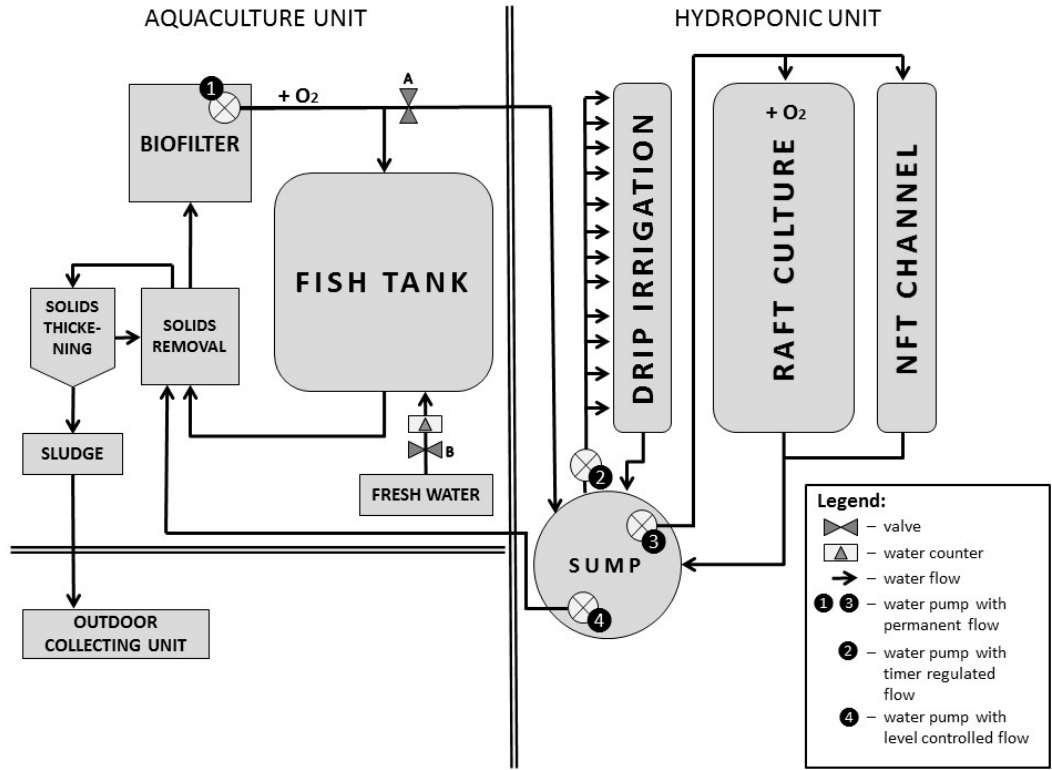
Figure 2. Water flow in the “Wädenswil aquaponic system” in 2014: Fresh water flowed through valve B, which was controlled by UrbanFarmers controller software (UrbanFarmers, Zurich, Switzerland), and an analogue counter to control the volume of water added to the fish tank. Water from the fish tank flowed continuously into the solids removal unit. From here, solids-free water flowed under gravity into a moving bed biofilter. A circulation pump ❶ pumped water (5 m 3 ·h − 1 ) from a biofilter through an oxygenation cone, and back to the fish tank. The heating element in the biofilter ensured a constant water temperature of 29 °C. Twice an hour computer controlled valve A opened the water flow to the hydroponic unit into the sump for 2 min, providing an exchange of 2448 ± 155 L·day − 1 . The time regulated pump ❷ pumped water to the drip irrigation hydroponic unit (31 March–1 October, irrigation every 15 min for 2 min, and 1 October–5 November, irrigation every 10 min for 2 min). The pump ❸ constantly pumped water into the floating raft culture, and NFT channel and from there via the drainage point back to the sump. The return pump ❹ pumped water back to the solids removal unit and thus ensured a constant water level in the sump. During automatic drum filter rinsing with cleaned system water, small amounts of water with solids (fish manure and residues of fish feed) were removed into solids thickening unit, as described in Mayer [23]. Thickened floating, and settled sludge was manually removed from the system three times a week and collected in an outdoor unit. Solids-free water was returned to the solids removal unit.